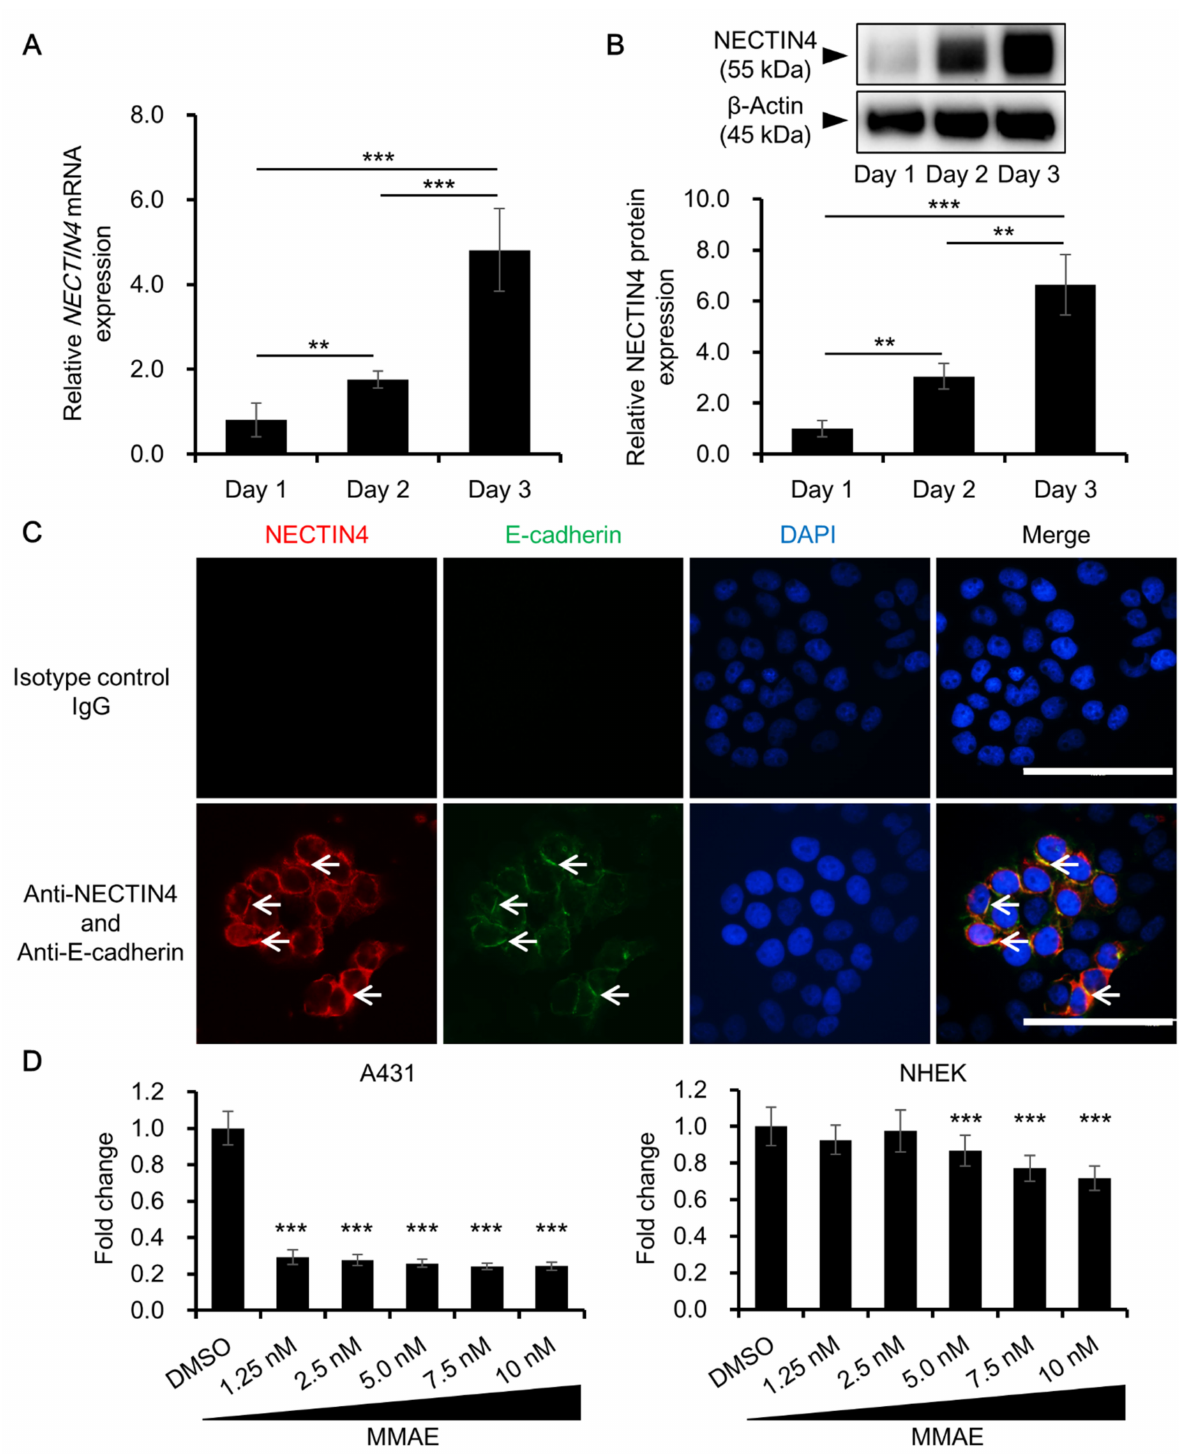
Figure 2. NECTIN4 expression in A431 human SCC cells. ( A , B ) Relative NECTIN4 expression in A431 cells at the mRNA ( A ) and protein ( B ) levels on days 1–3. Data are the mean ± SD ( n = 3). ** p < 0.01, *** p < 0.001. ( C ) Representative immunocytochemical images of NECTIN4 and the membrane marker E-cadherin in A431 cells. Arrows indicate areas where NECTIN4 staining overlaps with E-cadherin staining. Scale bars = 100 µ m. ( D ) Mean ± SD viability of A431 cells (left) and normal human epidermal keratinocytes (NHEKs) (right) treated for 48 h with dimethyl sulfoxide (DMSO) (0.1%) or different concentrations of monomethyl auristatin E (MMAE), as indicated. Experiments were independently repeated three times and performed in five wells for each concentration. *** p < 0.001 compared with DMSO (vehicle